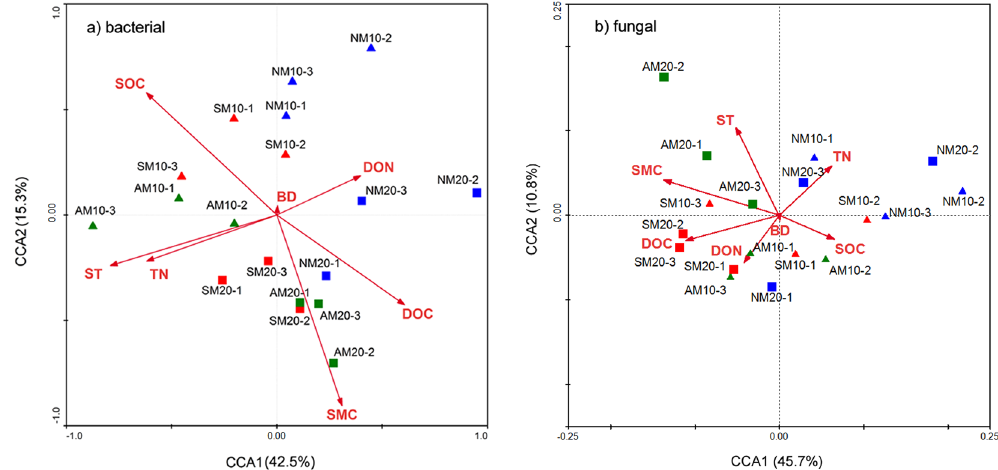
Figure 6. Canonical corresponding analysis (CCA) of bacterial ( a ) and fungal ( b ) community compositions with environmental variables. (10, surface soil 20, subsurface